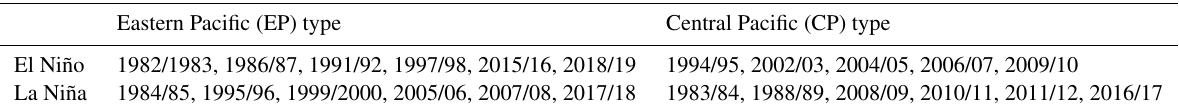
Table 1. Two types of ENSO events during